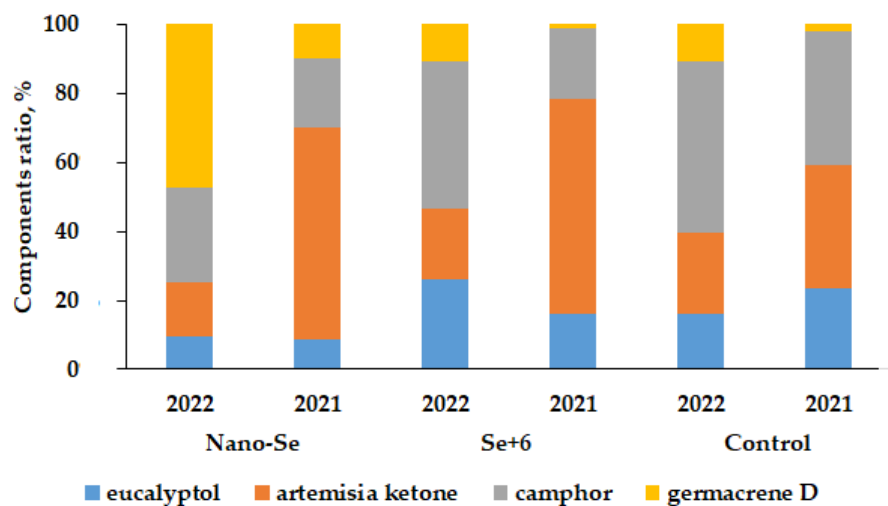
Figure 3. The main components ratio in A. annua essential oil without and under Se supply in 2021–2022.